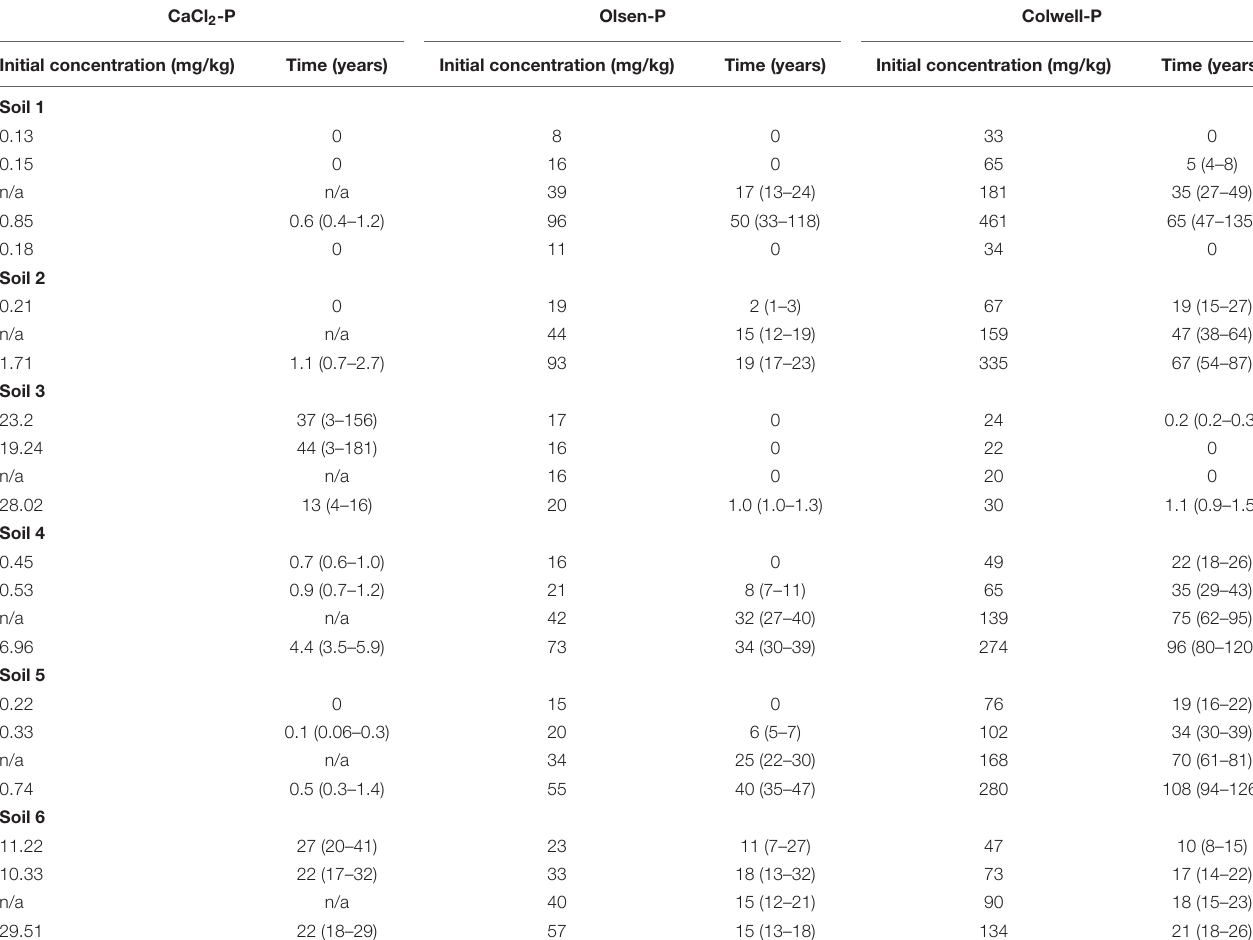
TABLE 5 | Modelled mean time (years) and range in time (in brackets) until various initial CaCl 2 -P, Olsen-P and Colwell-P concentrations (mg/kg) reach environmental threshold or agronomic optima, averaged across all on-going P ferts for each